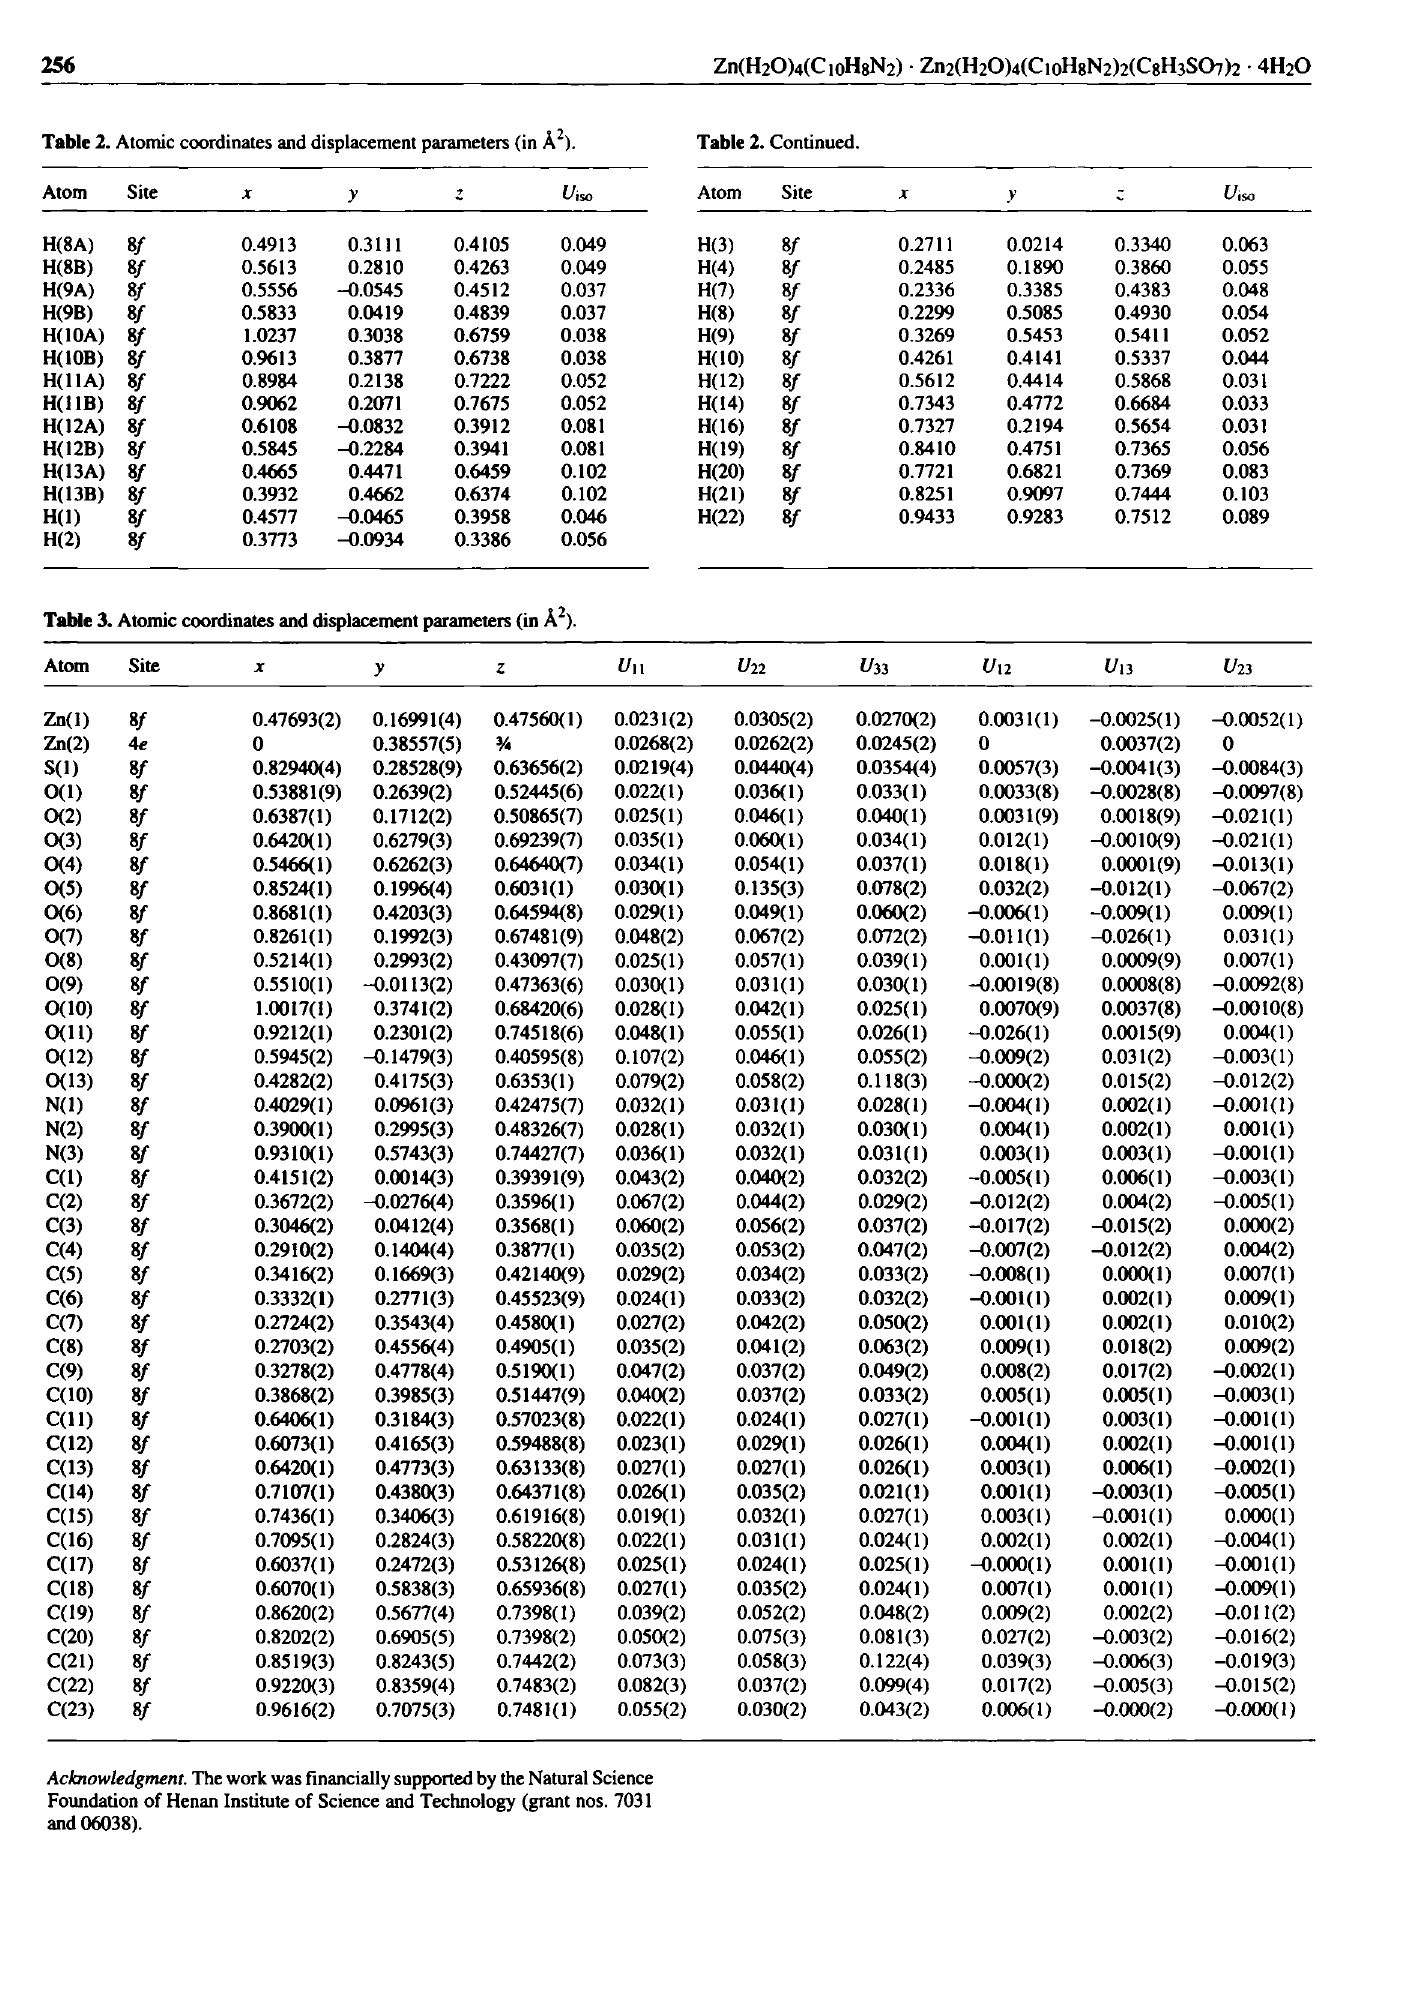
Table 2. Atomic coordinates and displacement parameters (in À 2 ). Table 2. Continued.